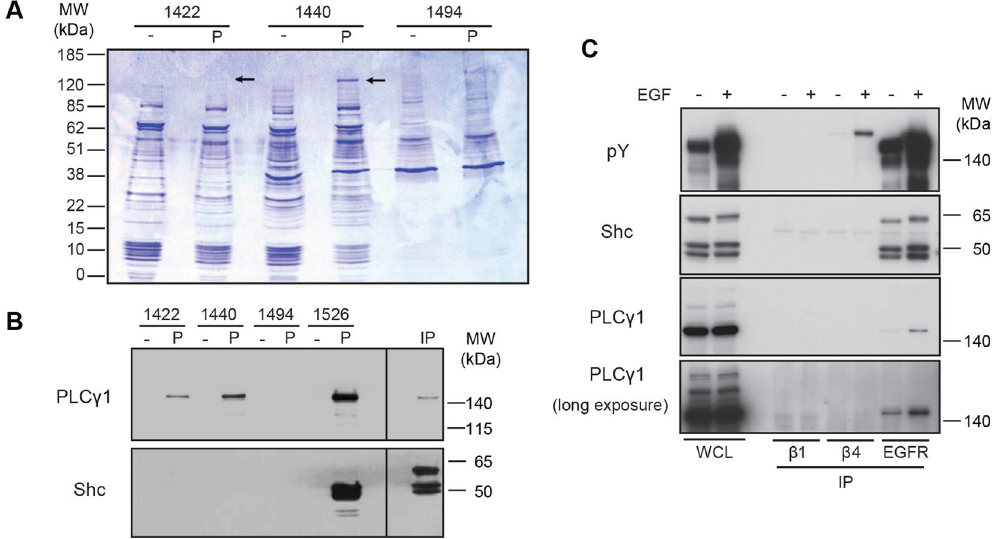
Figure 4. β4 tyrosine phosphorylation might provide a docking platform for PLCγ1. ( A ) A431 cells were lysed and different synthetic phosphorylated (P) and unphosphorylated (–) peptides derived from β4 were used for immunoprecipitation (IP). IPs were separated on gel and stained with Coomassie blue. The arrows indicate the protein band identified by mass spectrometry as PLCγ1. ( B ) A431 cells were lysed and different phosphorylated (P) and unphosphorylated (–) synthetic peptides derived from β4 were used for IP. IP samples were analyzed by Western blot for Shc and PLCγ1. ( C ) A431 cells were serum starved and subsequently treated with EGF for 5 min. A431 WCL and β1, β4 and EGFR IP samples were analyzed by WB for phospho tyrosine, Shc and PLCγ1. Molecular weight (MW) markers are indicated. Uncropped images of merged chemiluminescent and colorimetric blots obtained with a ChemiDoc imaging system (BioRad) are shown in Suppl. Fig.